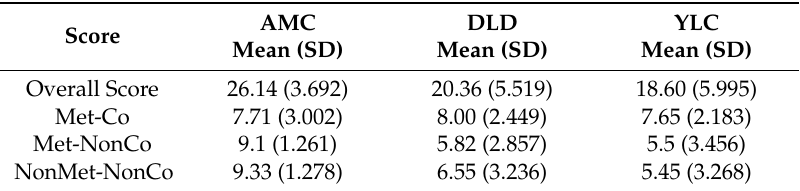
Table 3. Accuracy scores by condition and